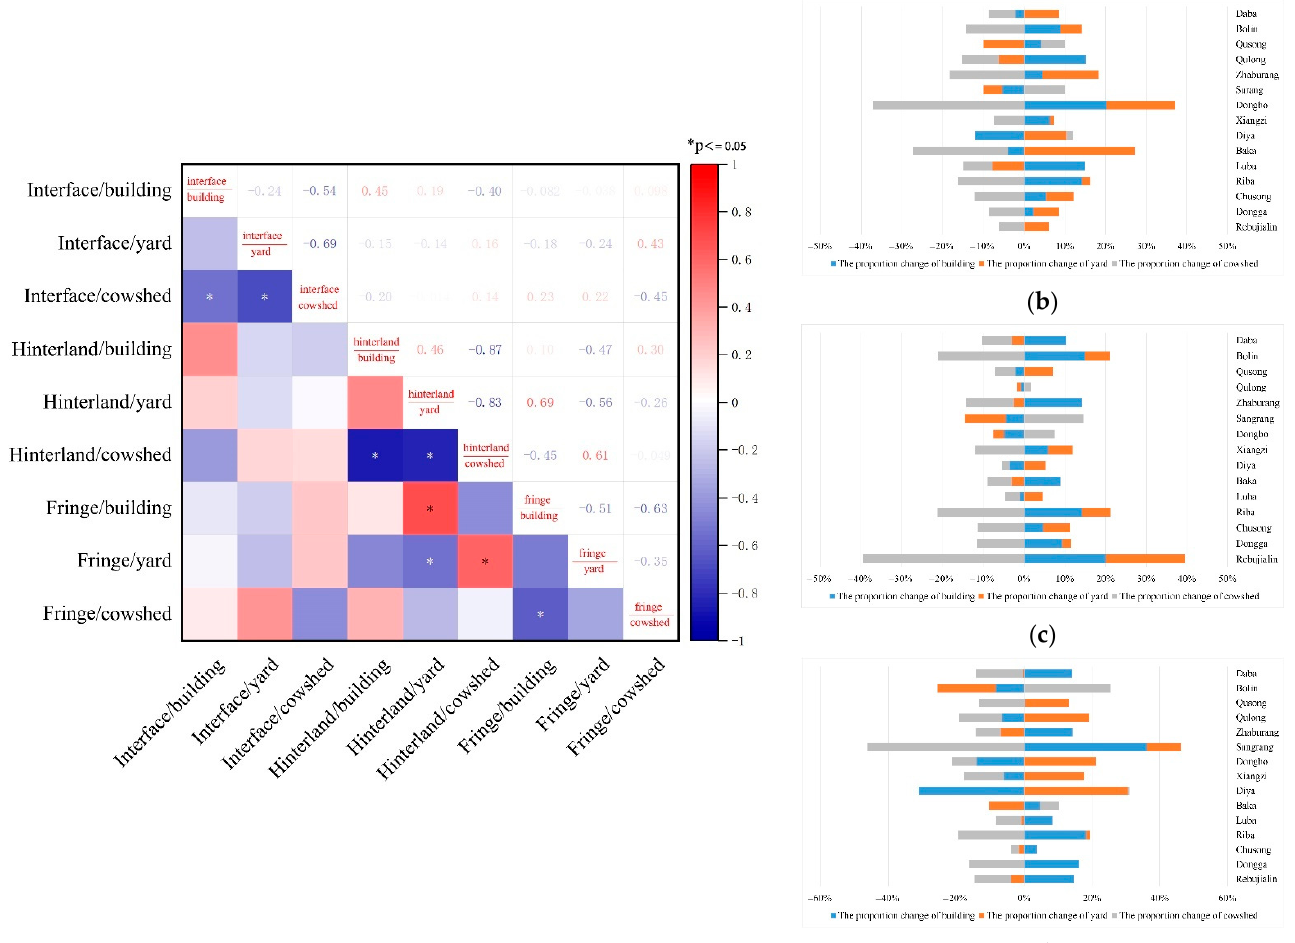
Figure 11. Land feature change in rural settlement construction. ( a ) The correlation of typical element proportion change in each spatial division. ( b ) The proportion change in interface area. ( c ) The proportion change in hinterland. ( d ) The proportion change in fringe area